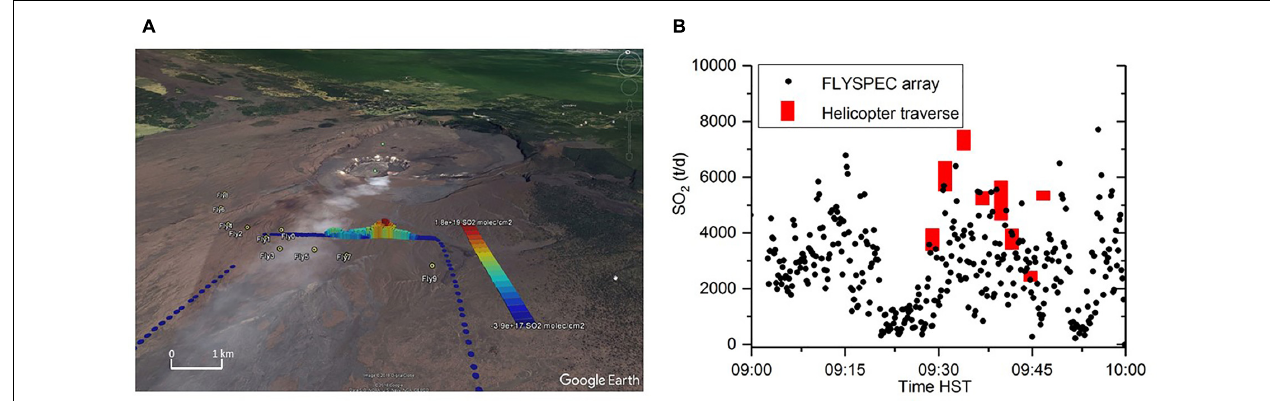
FIGURE 7 | (A) SO 2 column amounts during helicopter traverses measured with an upward-looking DOAS between 09:26 and 09:51 HST on 29 June 2017. The tracks are 3 ∼ km downwind of the vent and the warmer colors (yellow, orange, red) indicate higher SO 2 column amounts. Note that the plume center is located between array stations F7 and F9, likely contributing to underestimated values by the array as compared to the helicopter traverse.Image ©2018 DigitalGlobe. ©2018 Google. (B) Time series of 10-s SO 2 emission rates measured by the spectrometer array (black dots) between 09:00 and 10:00 HST on 29 June 2017. Red bars indicate the range of plausible SO 2 emission rates derived from upward-looking DOAS traverses on a helicopter at the location of the array (first five measurements) and ∼ 3 km farther downwind (last 3 measurements) using the various spectral retrieval methods described in section “Calculating SO 2 Column Densities From UV-Spectral Data.” The plotted times for the 3 downwind measurements were adjusted to account for plume travel time.